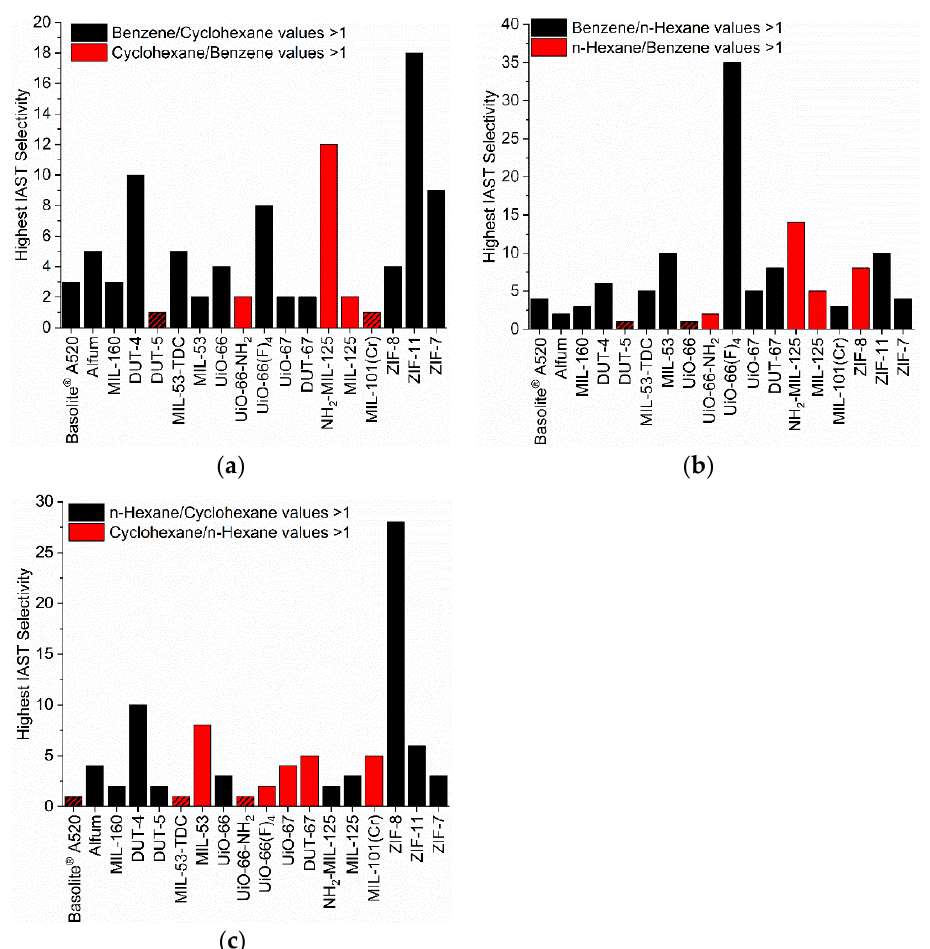
Figure 7. Highest values of the IAST selectivities from the three points at 0.01, 0.05 and 0.09 bar of each MOF for the different VOC pairs (50/50 molar ratio ( a ) benzene/cyclohexane, ( b ) benzene/ n- hexane and ( c ) cyclohexane/ n -hexane). The IAST selectivities of 1 are visualized via crosshatched bars. For the IAST-calculated selectivity dependence with pressure, see Figures S102 – S112. Further, ZIF-11 has a selectivity of 18 for benzene/cyclohexane and UiO-66(F) 4 of 13 –